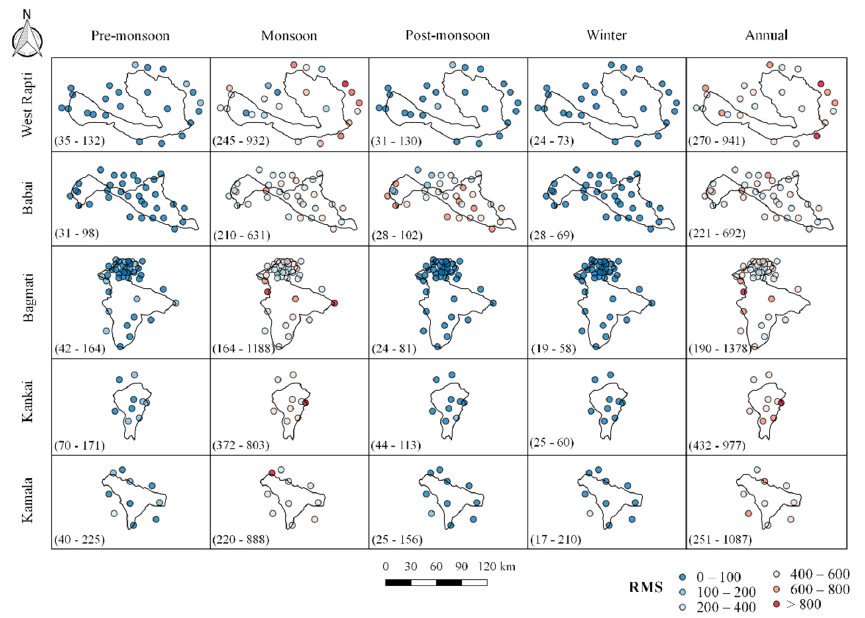
Figure 5. Spatial distributions of RMS between the CHIRPS product and rain gauge observation at the seasonal and annual scales.